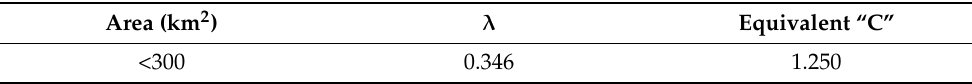
Table 5. Adopted Giandotti’s reduction coefficient (Source: [26]).